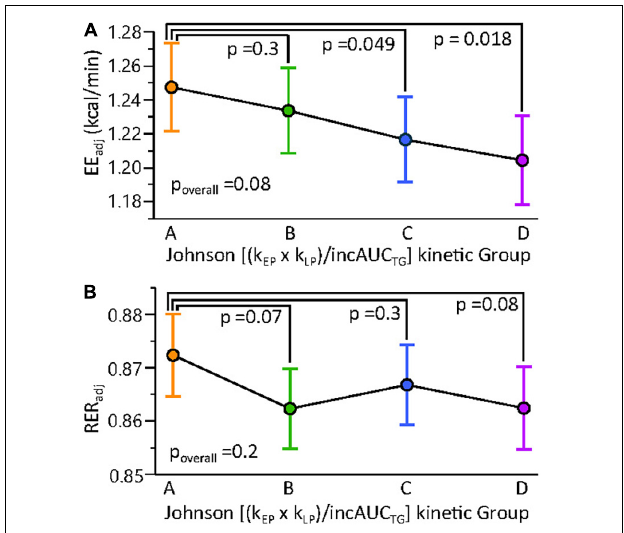
FIGURE 8 | Resting and postprandial energy metabolism shows subtle differences among MMTT triglyceride kinetic response groups. Mixed models of (A) resting and postprandial energy expenditure (EE) and (B) the respiratory exchange ratio (RER) were constructed using lean body mass, BMI, time, and the Johnson (k EP x k LP )/incAUC TG kinetic quartile group as fixed effects and the participant as random effect. Results are adjusted least square means ± standard errors. Results of contrast post-tests of Group A vs. other kinetic groups are shown. Constructing the same models with Johnson (k EP x k LP )/incAUC TG as a continuous variable indicated a negative correlation between this factor and EE ( p = 0.0056) but not RER ( p =